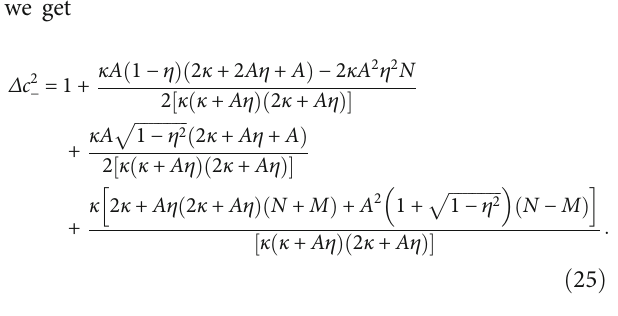
ffiffiffiffiffiffiffiffiffiffiffiffi 1 − η 2